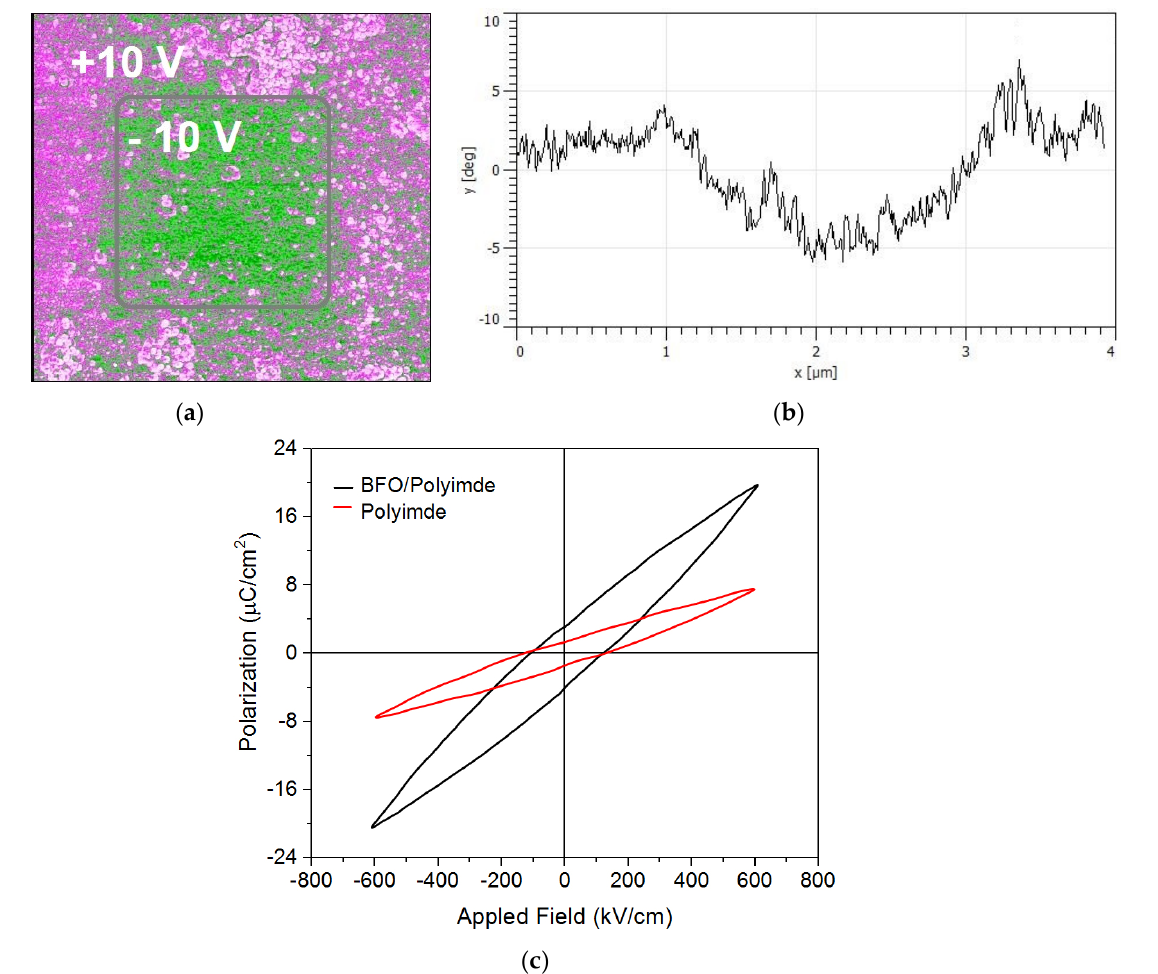
Figure 7. ( a ) PFM area 4 × 4 µ m 2 of BFO film surface of sample 2; ( b ) phase change along the line; ( c ) polarization-electric field (D–E) hysteresis loop curve for pure polymer and BFO/polyimide composite at 1 kHz.